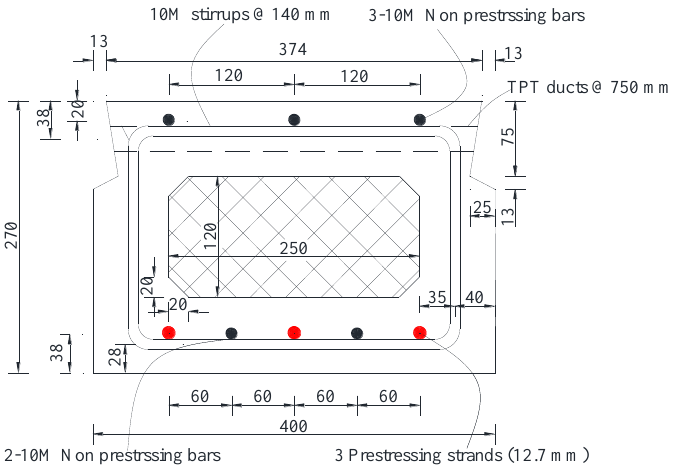
Figure 2. Reinforcement details of an interior girder (dimensions in mm).